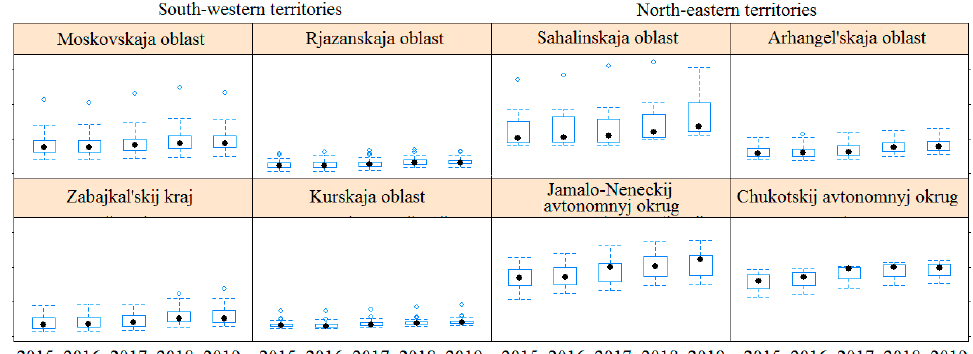
Figure 4. Box plots for the volume of social transfers and the population taxable income per capita in certain regions of Russia in 2015–2019.